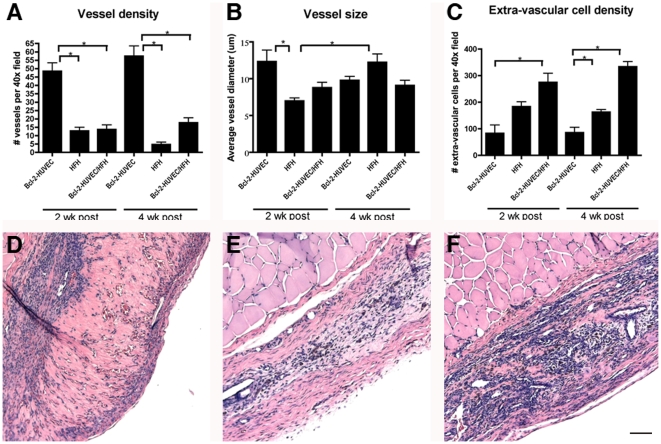
Quantitative analysis of vessel and extra-vascular cell numbers in gels incorporating Bcl-2-HUVEC and/or HFH.Panels A-C show vessel density and size (A and B, respectively) and number of extra-vascular cells (C) calculated from H&E-stained sections of vascularized gels harvested at 2 and 4 weeks post-engraftment. Results are expressed as the mean ± standard error of the mean (SEM) and asterisks indicate significance at p≤0.05. Panels D–F show representative H&E-stained micrographs from gels harvested at 4 weeks post-engraftment containing Bcl-2-HUVEC (D), HFH (E), and HFH/Bcl-2-HUVEC (F). Size bar: 100 µm.